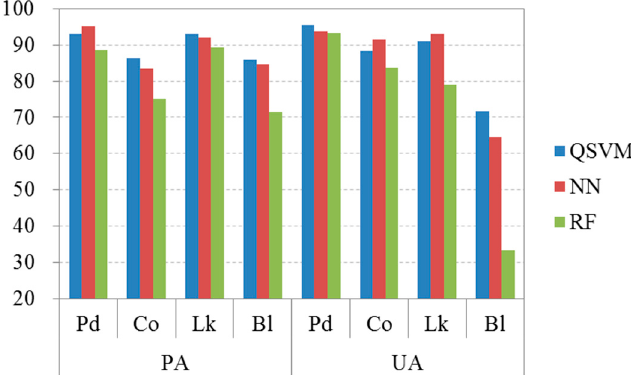
Figure 9. A bar chart representing the producer and user accuracies for the three classifications of tree crowns classified using the quadratic SVM (QSVM), neural network (NN), and random forest (RF) approaches with the highest overall accuracy. Pd, Pinus densiflora ; Co, Chamaecyparis obtusa ; Lk, Larix kaempferi ; Bl, broadleaved trees; PA, producer accuracy; UA, user accuracy.